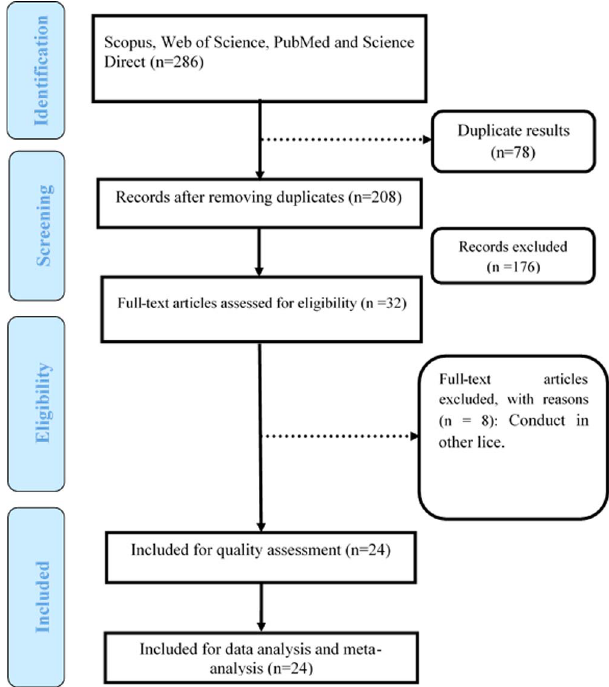
Figure 1. The PRISMA fl ow chart